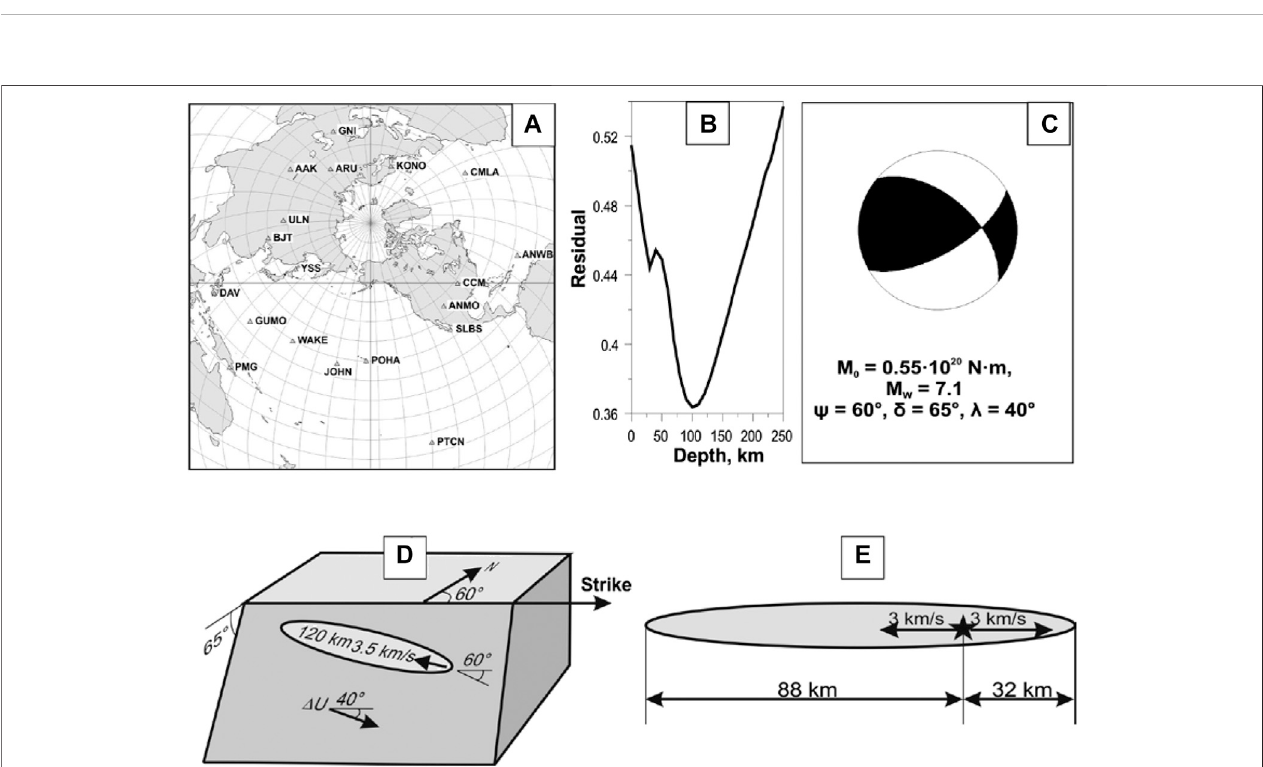
FIGURE8| Modelingthe January 24, 2016,M W 7.1 earthquake: (A) stations used todetermine parametersoftheearthquake inthedoublecouple approximation, (B) source depth residual function, (C) focal mechanism, (D) the earthquake focal model, (E) one-dimensional bilateral model of faulting oriented along the centroid velocity. Notes: the map (A) is centered at the epicenter ofthe major earthquake; M 0 , M W , ψ , δ , λ , and Δ U are seismic moment, moment magnitude, strike, dip, slip, and vector of slip direction, respectively.